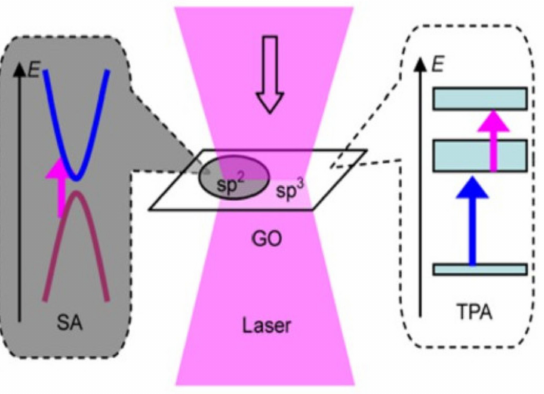
Figure 6. Absorption of light in GO. (Reproduced with permission from ref. [44]. Copyright 2012 El- sevier